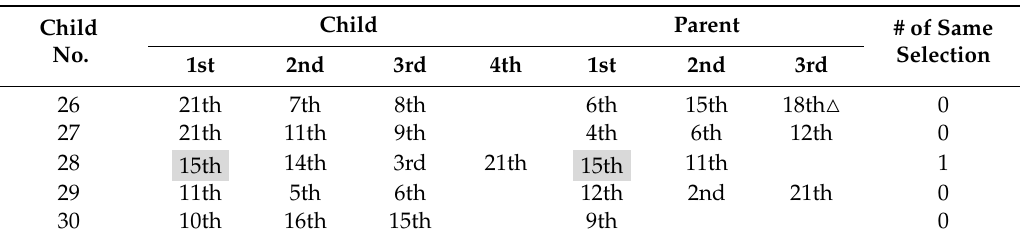
independent are marked with “ (cid:52) ”; other unmarked items indicate an intention to do more. Item names: 1st. Personal care; 2nd. Family mealtime; 3rd. Looking after one’s own health; 4th. Gathering daily necessities